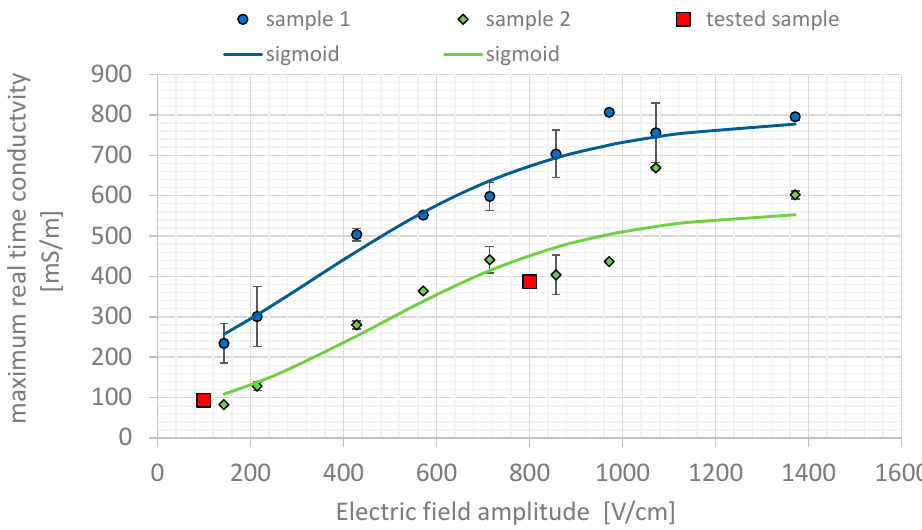
Figure 5. Conductivity as a function of the applied voltage in a PEF simulation scheme evaluated during the treatment. Table 2. Conductivity as a function of the applied voltage and parameter obtained fitting the model using Equation (5).